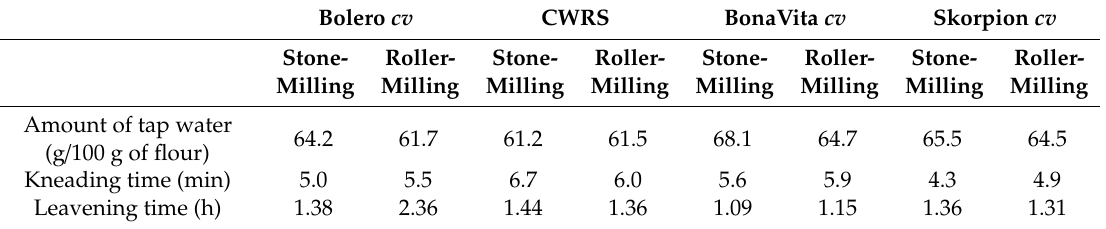
Bolero cv CWRS BonaVita cv Skorpion cv Stone- Roller- Stone- Roller- Stone- Roller- Stone- Roller- Milling Milling Milling Milling Milling Milling Milling Milling